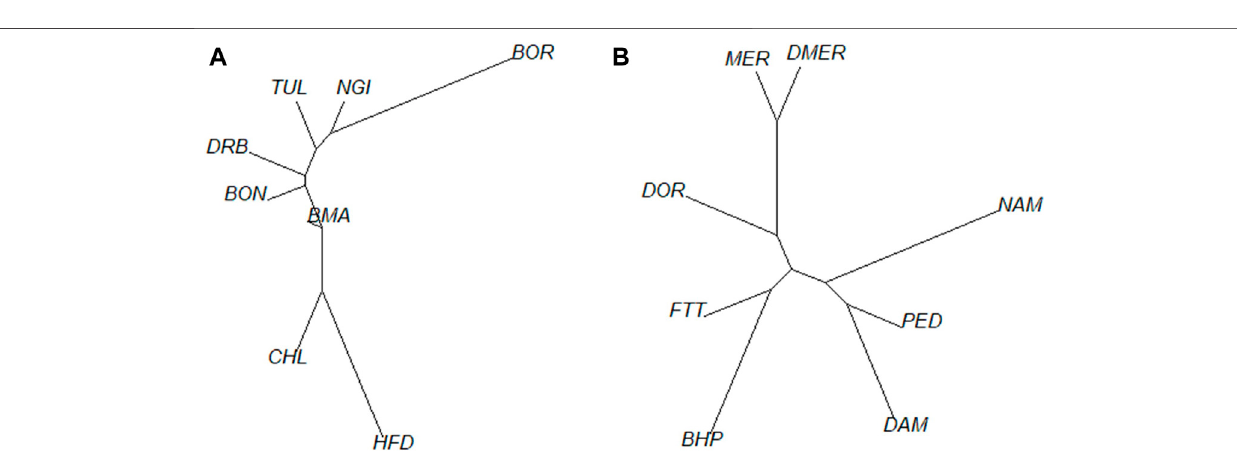
Frontiers in Genetics |